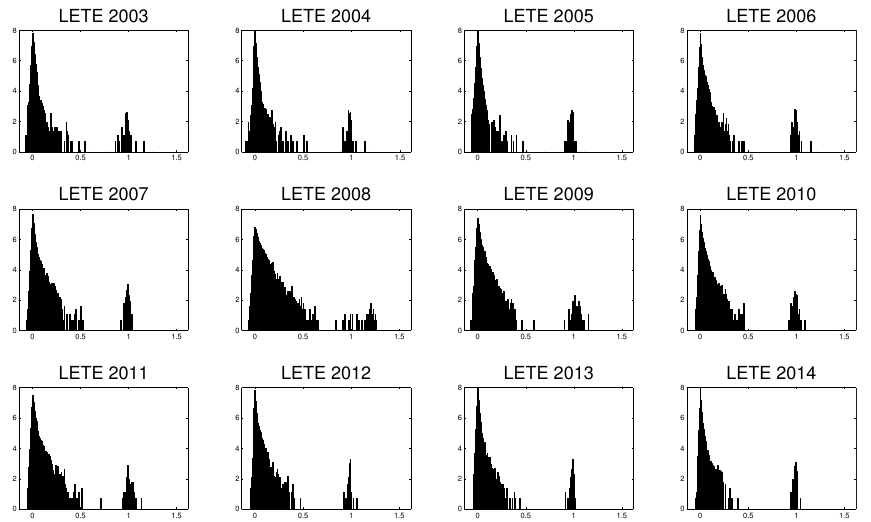
Figure 10. Logarithmic values of frequency distributions of the correlation matrices for each of the years of data for Sector 1 (original × original